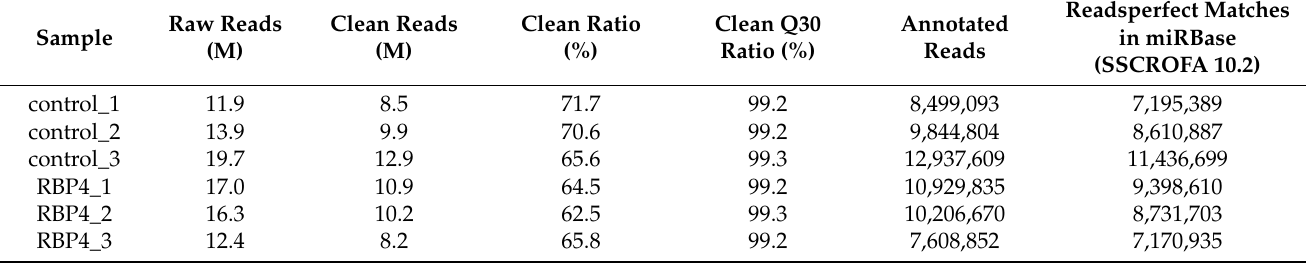
Table 1. Statistical analysis of sequencing data from the control group and RBP4 treatment group.